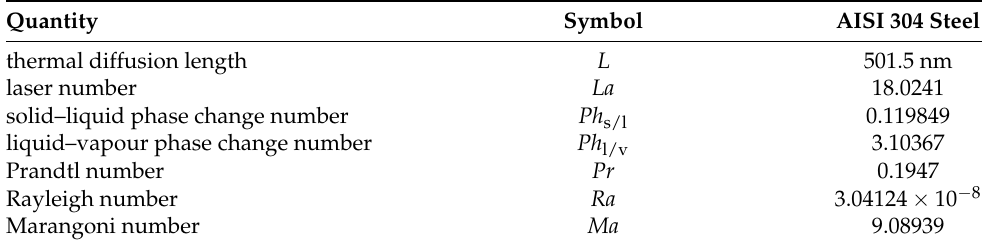
Table 3. Diffusion length and dimensionless numbers of DLIP model for stainless steel